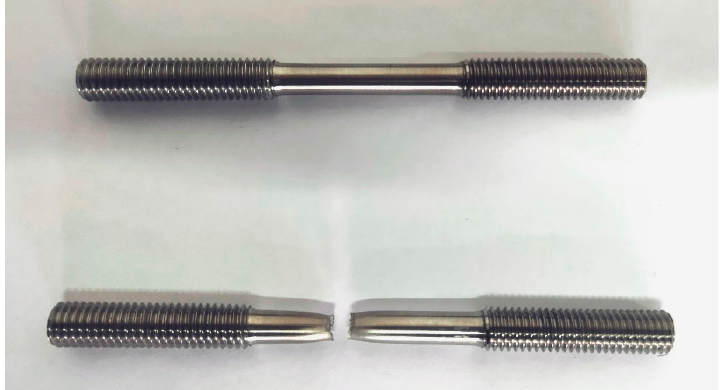
Figure 3. Tensile specimens before and after experiments.